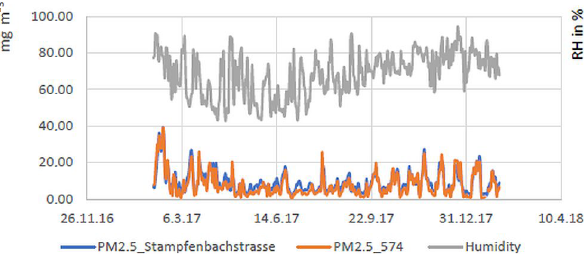
Figure 9. Monthly average PM and relative-humidity values for Schimmelstrasse.